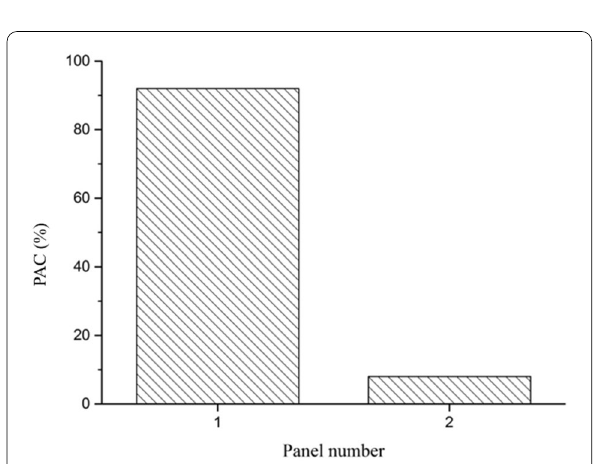
Figure 12 Noise reduction topology optimization model of single-stage gearbox for field point